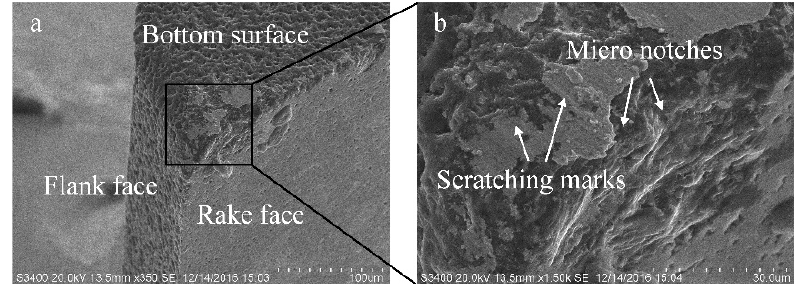
Figure 10. The PCD tool wear morphology. ( a ) Overview of the worn tool tip; ( b ) enlarged view of the tool wear region.